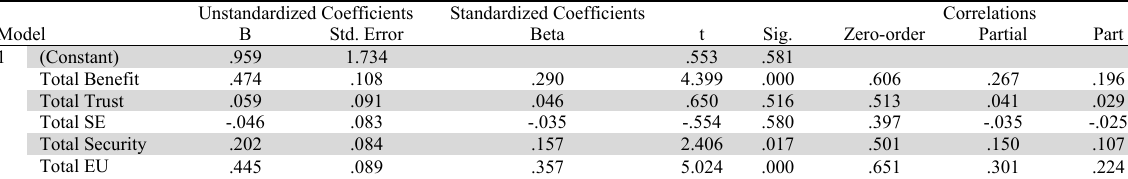
The summary of the regression analysis Model